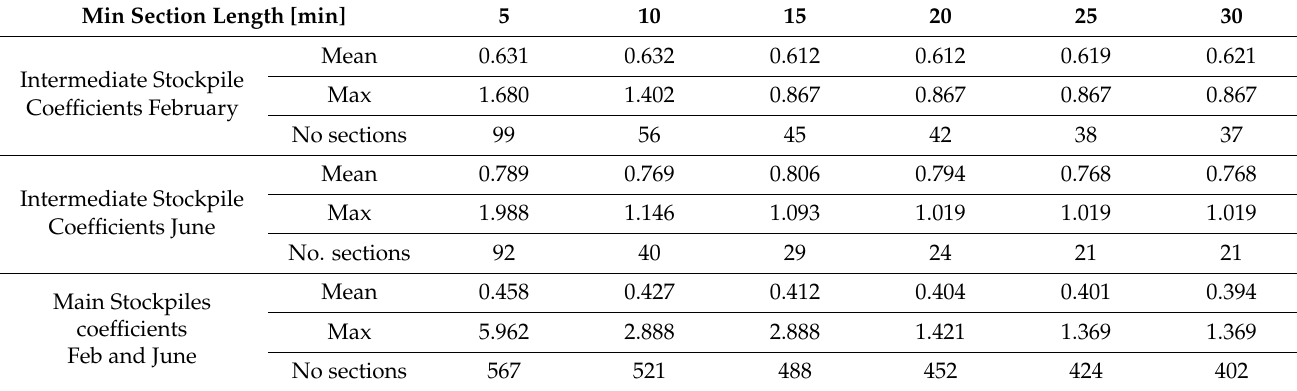
Table 1. Mean coefficients and number of separate unloading events at the intermediate February stockpile, the intermediate June stockpile, and the main